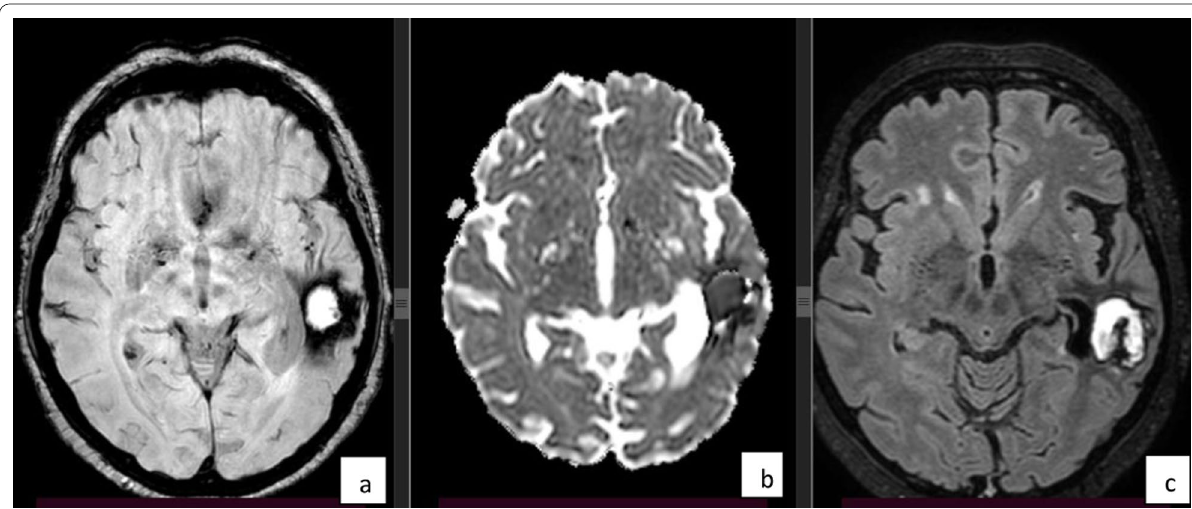
Fig. 3 a Axial SWI suggestive of left temporal HS with the signs of blood fragmentation. b Axial ADC maps show reduced values consistent with late subacute phase. c FLAIR shows a hyperintensive focus in the left temporal subcortical area with perifocal